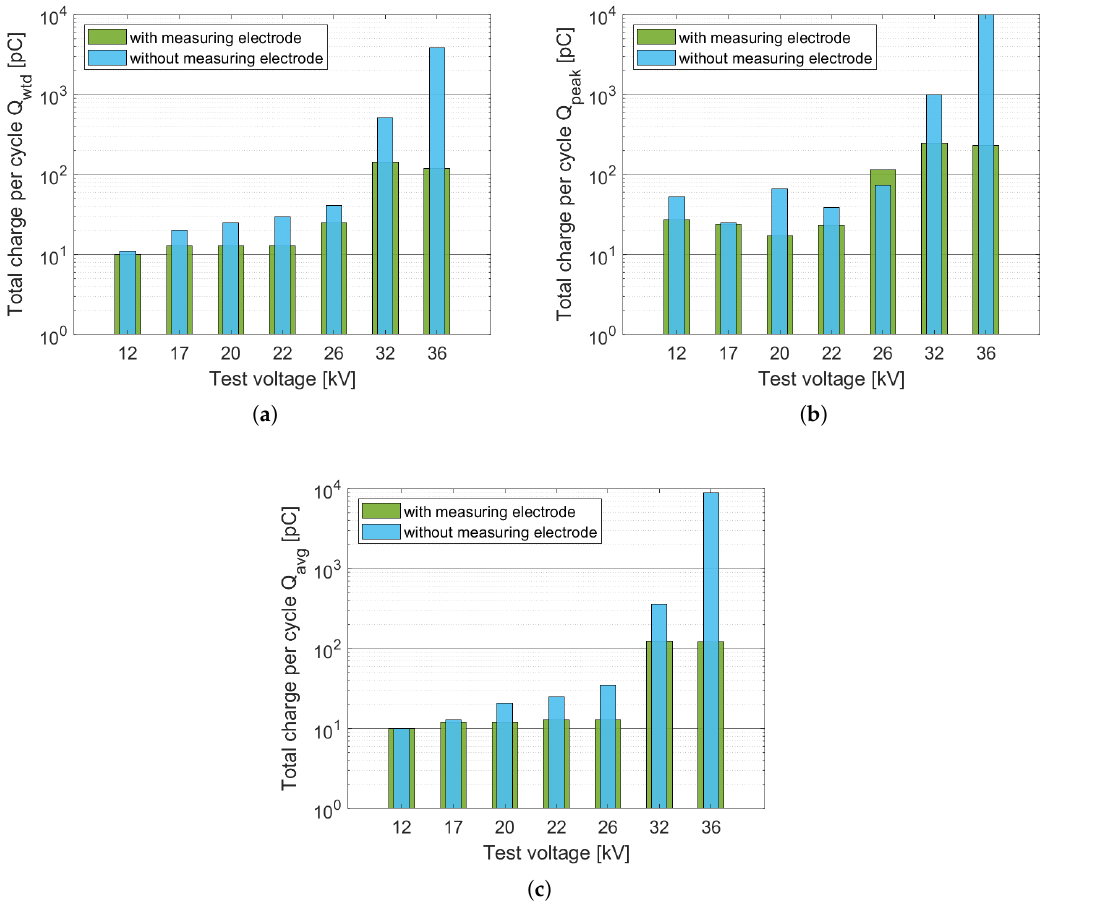
Figure 11. Graphical presentation of the value of Q depending on the U p for a cable in a configuration with installed and removed corona rings using the HF method: ( a ) Q wtd , ( b ) Q peak , ( c ) Q avg